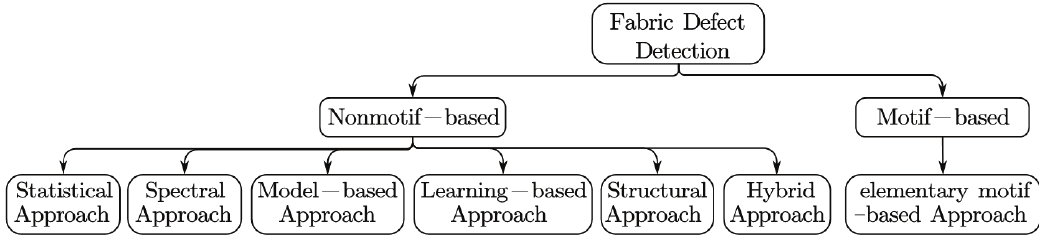
Figure 4. Different approaches for patterned fabric defect